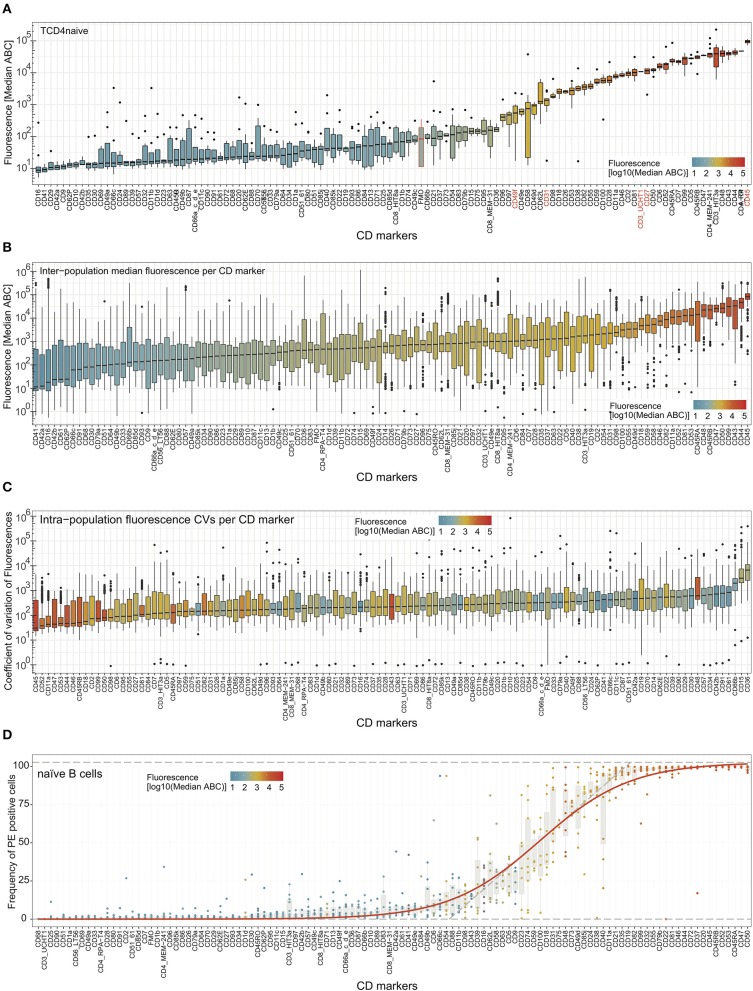
Expression levels and heterogeneity of expression of cell surface markers across cell types. (A) Median fluorescence (in antibody binding capacity; ABC) for all markers on one cell subset (naïve CD4 T-cells) ordered from low to high median expression. CD markers in red font are discussed in the main text, FMO is highlighted in orange, and a horizontal orange line depicts the median FMO background. Similar plots for all cell subsets are provided in Supplementary Figure 6. (B) Fluorescence (in ABC) across all cell subsets per CD marker with box whisker plots (median, IQR, and range). The CD markers are ordered from low to high median expression (black horizontal lines). (C) Coefficients of variation (CV) of expression across all cell subsets per CD marker. The CD markers are ordered from low to high median CV (black horizontal lines) as box whisker plots with the color representing the median expression level ABC. (D) Frequency of positive cells for all markers on one cell subset (naive B-cells) ordered from low to high frequency. Similar plots for all cell subsets are provided in Supplementary Figure 7. In all plots, fluorescence intensity is also represented by the coloring of the boxes.